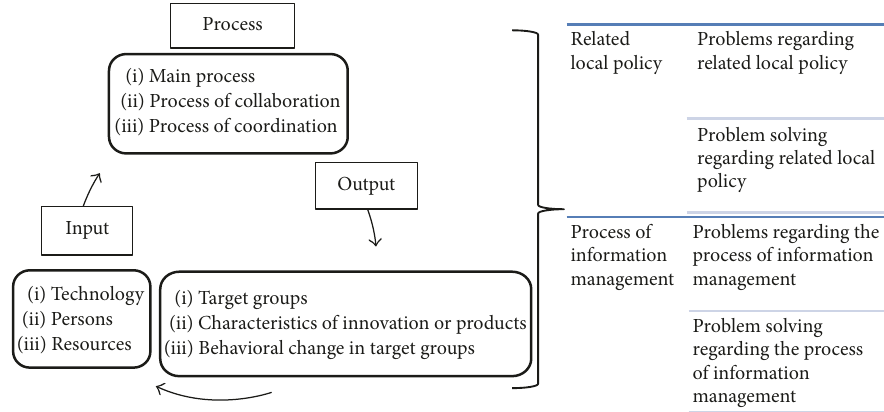
Figure 1: The information management system in community health at the district health